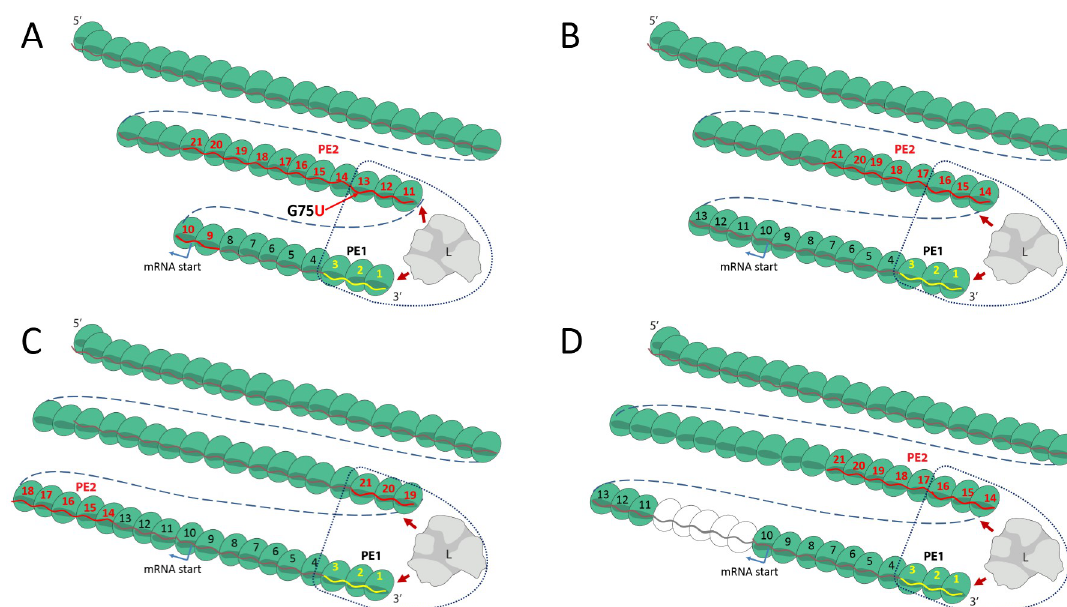
Fig 2. A paramyxovirus-like model for EBOV bipartite promoters, based on a variable and dynamic 3 0 end of the NC helix. The G75U and wt NC helices are schematically shown as 2-dimensional chains of NP subunits (green spheres), numbered from their 3 0 ends, whose first turn is either 10 (panel A), 13 (panel B), or 18 subunits long (panels C and D). The open spheres in panel D represent hexa-nt insertions in the wt minigenome. Their genome RNAs are shown as a wavy line within their NP RNA-binding grooves (darker green). PE1, modeled as the first 3 subunits, is highlighted in yellow. Subunits containing contiguous PE2 hexamer repeats (3 0 NN U RRN for EBOV/8U and 3 0 NNN U RR for EBOV/7U) are highlighted in red. The polymerase (L) is shown in gray, interacting with PE1 and the minimum PE2 tripartite repeat needed for the initiation of RNA synthesis. For further detail, see text. EBOV, Ebola virus; NC, nucleocapsid; NP, nucleoprotein; nt, nucleotides; PE1, promoter element 1; PE2, promoter element 2; wt, wild-type.